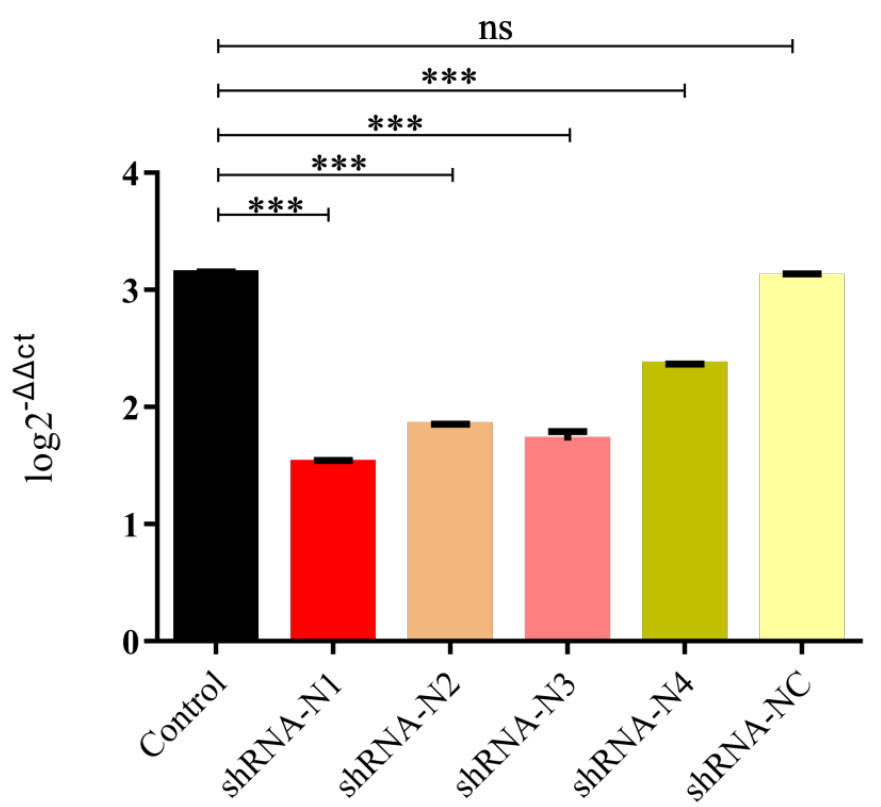
Figure 3. Inhibition of PDCoV replication by shRNAs in LLC-PK1 cells. qRT-PCR for the detection of the mRNA transcripts of the N gene of PDCoV relative to β -actin transcripts in the same sample. The data are presented as the mean values ± standard deviation for three independent experiments, and marked with three asterisks (***) if p < 0.001.